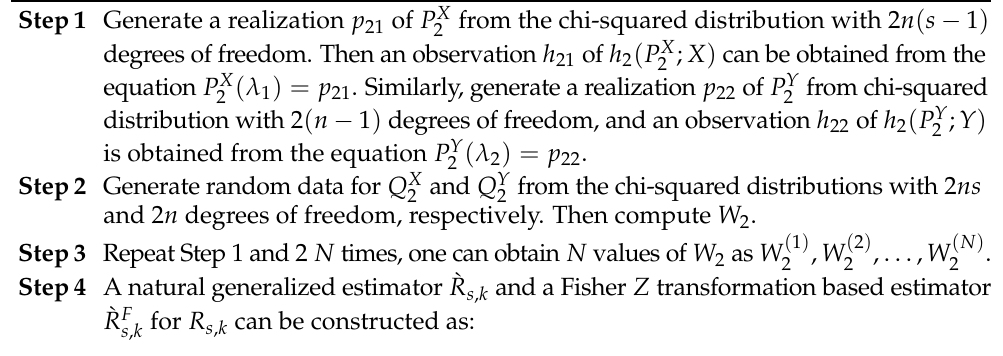
Algorithm 2: Pivotal based estimation for R s , k with unequal